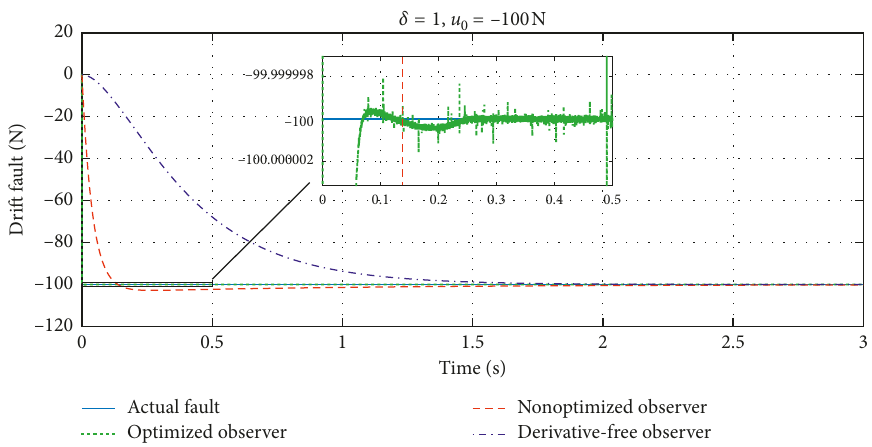
Figure 6: Tracking effects of the drift fault ( bump road